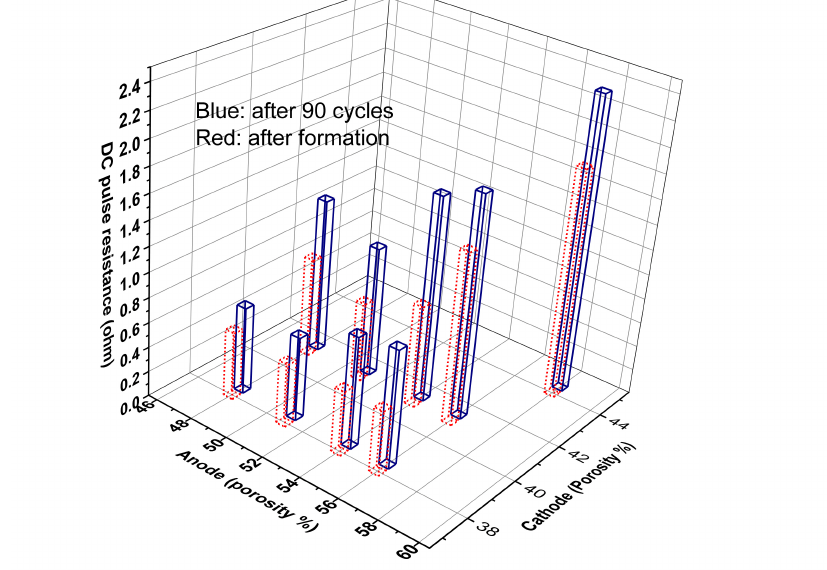
Figure 3. DC resistances of full cells obtained from Figure 2 plotted vs. anode and cathode porosity. Cell A with uncalendered electrodes and 44% cathode porosity and 58% anode porosity has the highest DC